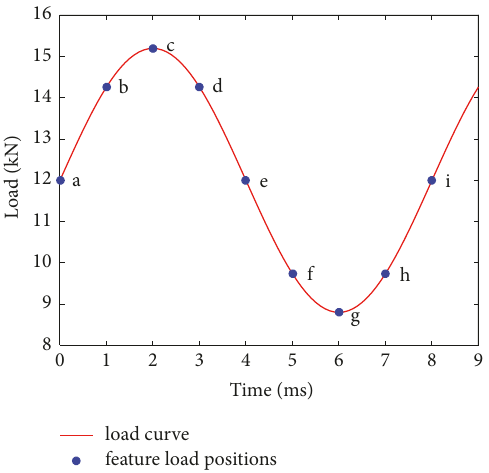
Figure 11: The characteristic load values within one stress cycle. zone in the horizontal direction of the crack tip is about